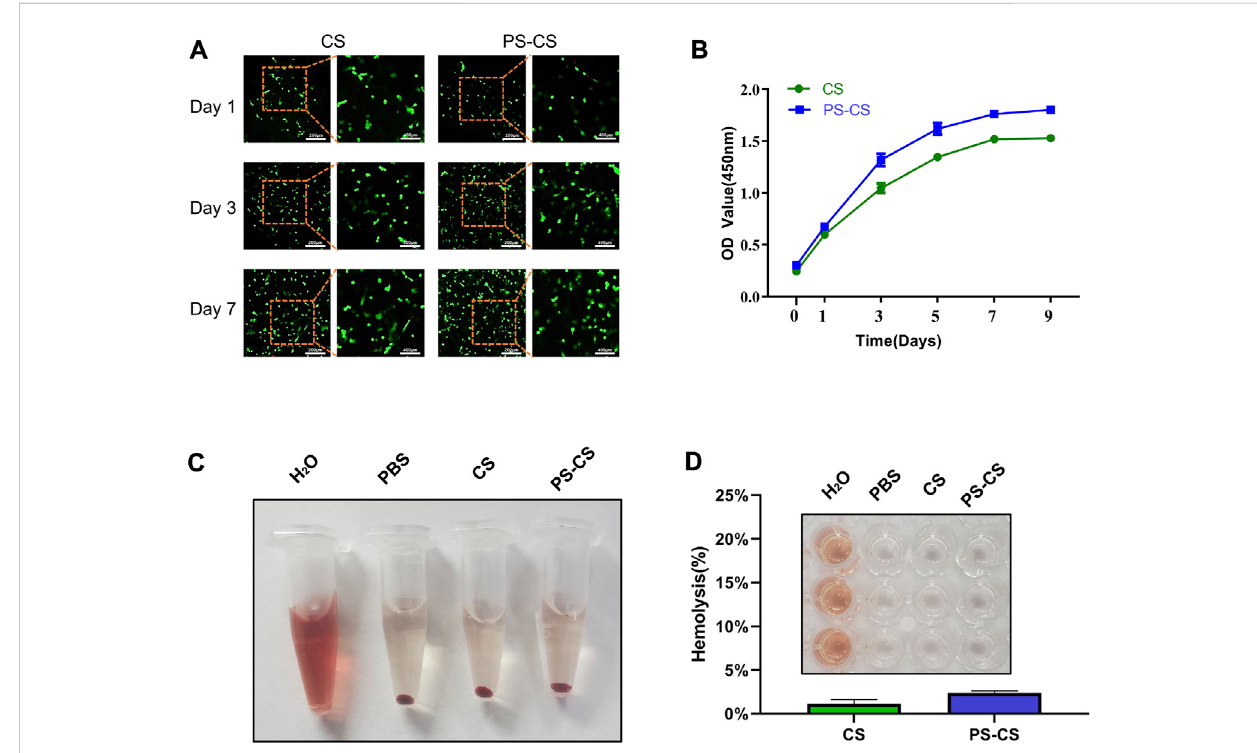
FIGURE 3 The cell viability of BMSCs in the membranes. (A) Live/Dead assay images of BMSC-encapsulated CS and PS-CS membranes upon 1, 3, 7 days of incubation. (B) CCK-8assayofBMSC-encapsulatedCSandPS-CSmembranesupon1,3,5,7,9 daysofincubation.Hemolysisassays. (C) Imagesoftubes showing hemolytic activity by CS membranes and PS-CS membranes. Sterile H 2 O was used in the positive control group; PBS was used in the negative control group. (D) The hemolysis rate of each sample. Images of 96-well plate showing hemolytic activity by different groups of H 2 O, PBS, CS,